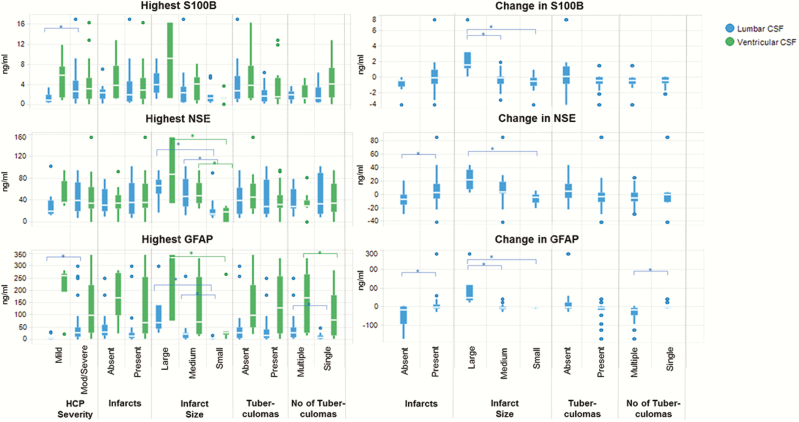
Association between radiology overall and neuromarker concentrations. These box and whisker plots demonstrate the median, interquartile range, and range of the highest neuromarker concentrations (panel 1: lumbar and ventricular cerebrospinal fluid [CSF]) and the change between admission and week 2 (panel 2: lumbar CSF only; a positive value indicates an increase over time) for various radiologic features recorded across admission and in-hospital follow-up scans (overall computed tomography and magnetic resonance imaging). Statistically significant results are indicated by a square bracket and *. Hydrocephalus was scored on admission scans and dichotomized as mild and moderate/severe. There were very few patients with mild hydrocephalus. Abbreviations: CSF, cerebrospinal fluid; GFAP, glial fibrillary acidic protein; HCP, hydrocephalus; NSE, neuron-specific enolase.